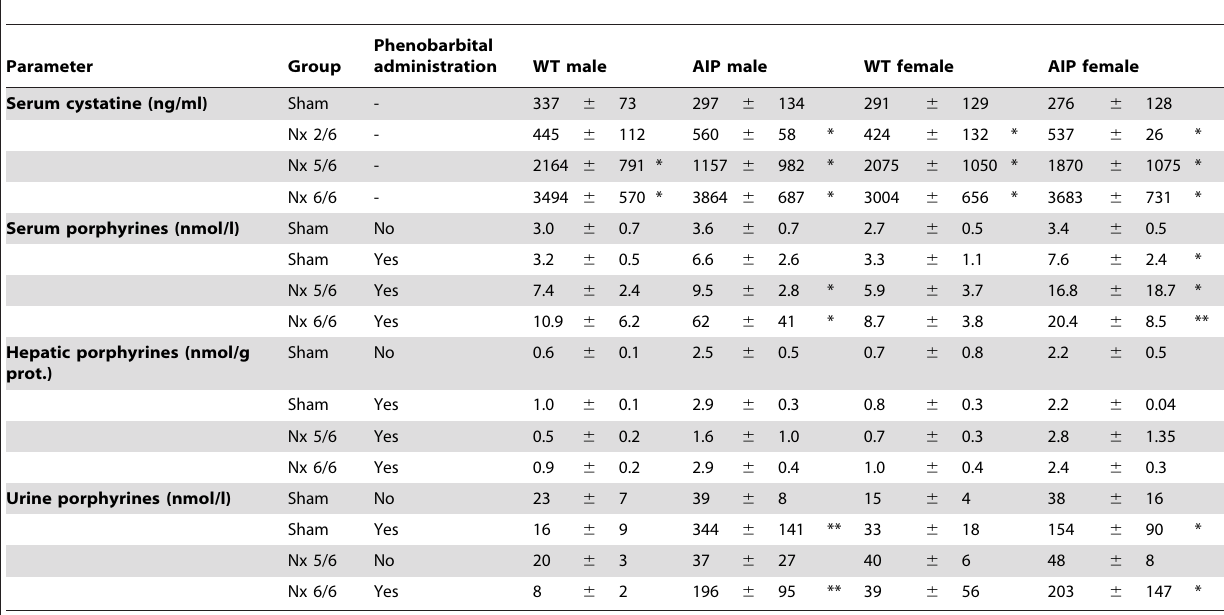
Table 1. Serum cystatine and porphyrin levels in wild type and AIP mice with different degrees of chronic renal failure.